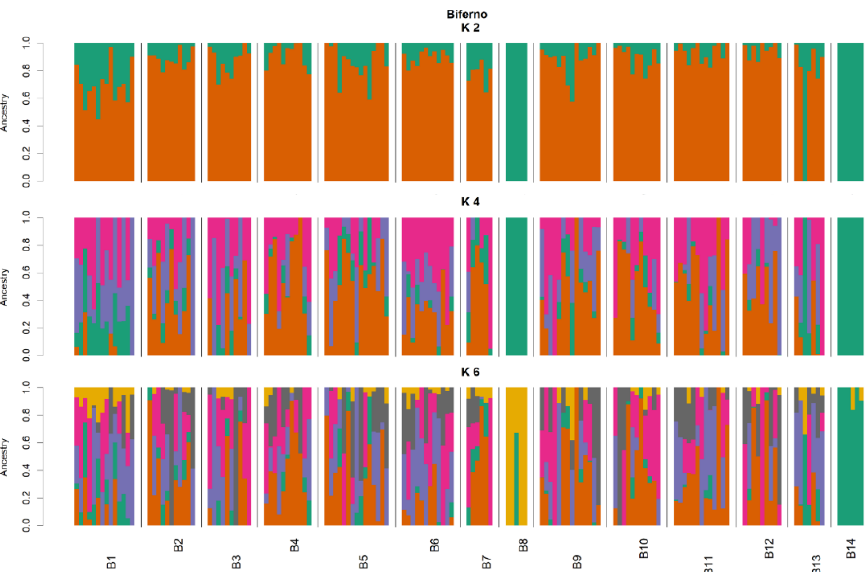
Figure 4. ADMIXTURE results at K = 2, K = 4 and K = 6 on Biferno genotyping data. Assignment of single individuals (thin vertical bars) to different clusters. Different colors identify different clusters. The reconstruction at K = 2 had the smallest cross-validation error (see Figure S1).